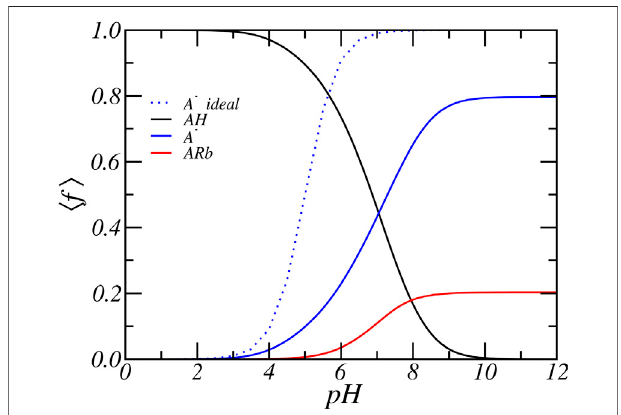
FIGURE 4| The radial cylindrical number density distribution of the total, and the protonated, deprotonated and Rb + condensed Glu acid residues of thePA-nano fi ber.ForareservoirpHof7.4andaRbClconcentrationof[RbCl]= 50 mM . The inset shows the relative dielectric